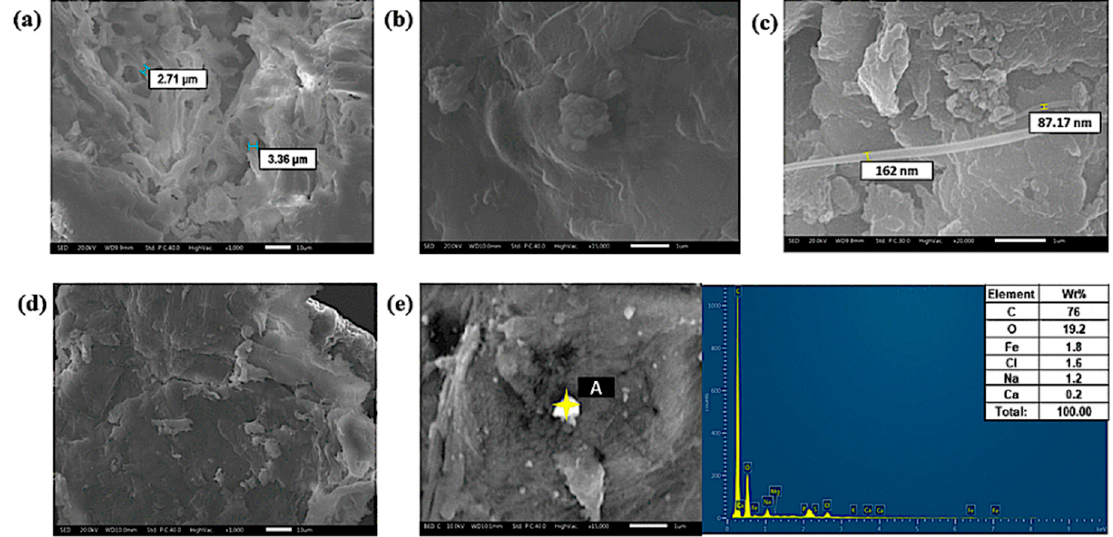
Figure 1. Scanning electron microscopy (SEM) micrographs of Cellulose nanofibers (NFCs): ( a ) X1000, ( b ) X15,000, ( c ) X20,000; iron nanoparticles and cellulose nanofibers (FeNPs/NFCs): ( d ) X1000, ( e ) X1500.